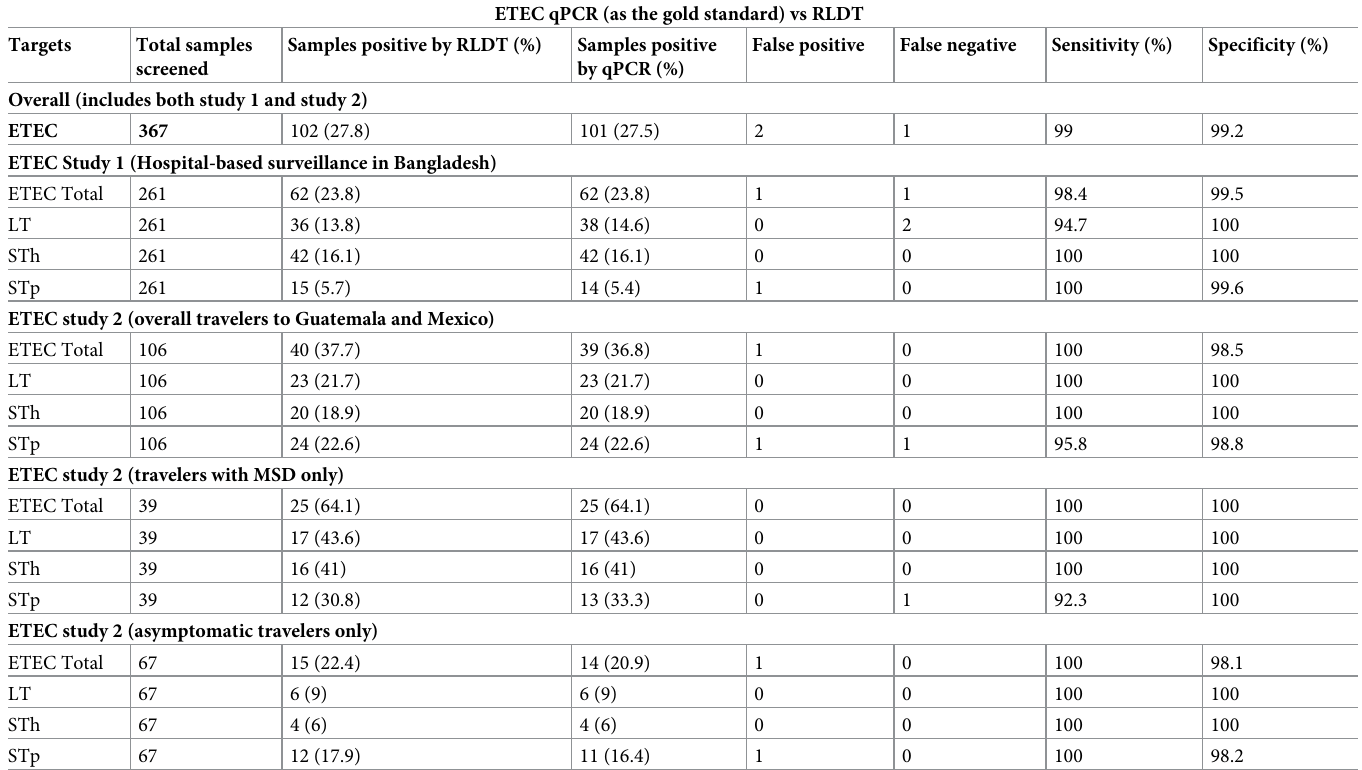
Table 1. Sensitivity and specificity of ETEC RLDT compared to qPCR.